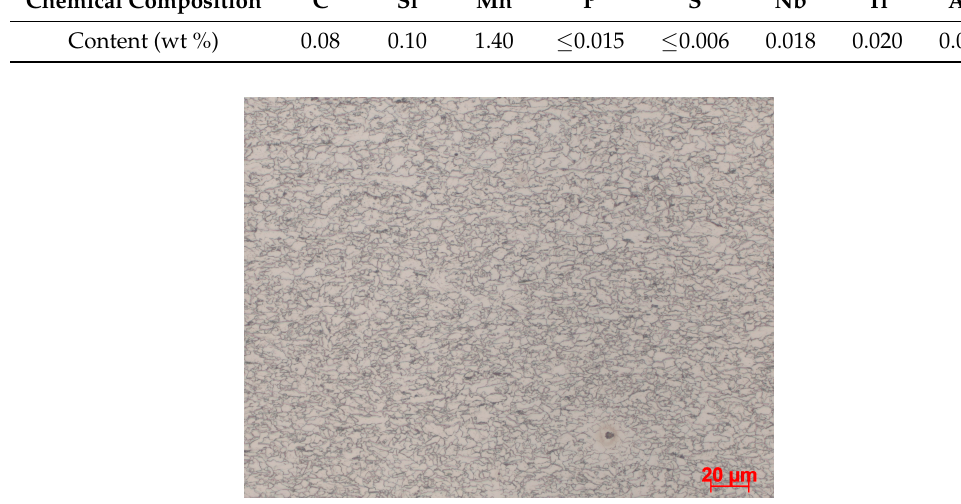
Figure 1. Microstructure of high strength steel B550CL.